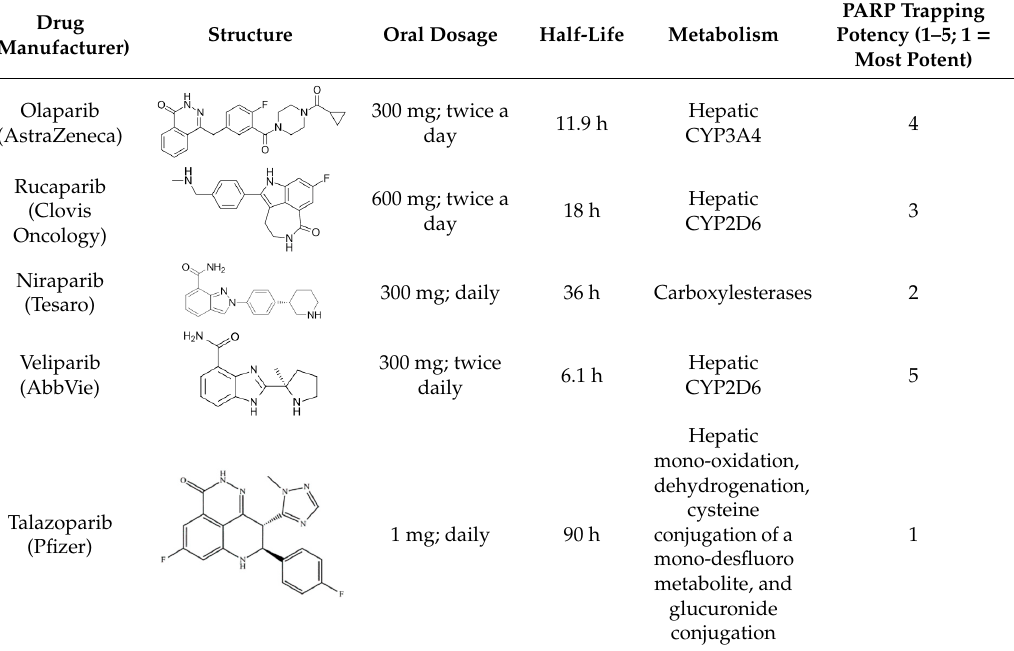
Table 1. Pharmacokinetics of current Poly (ADP-ribose) polymerase inhibitors (PARPi).